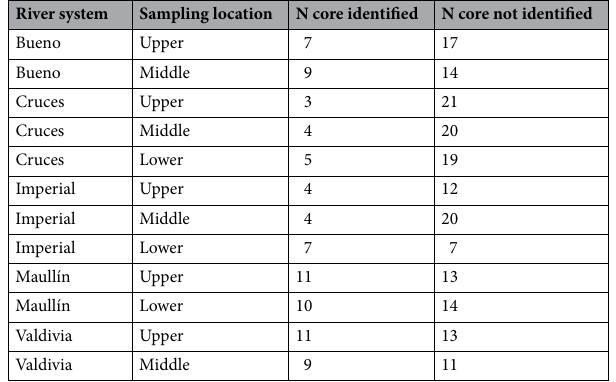
Table 1. Number of individuals with cores captured in the river systems evaluated.